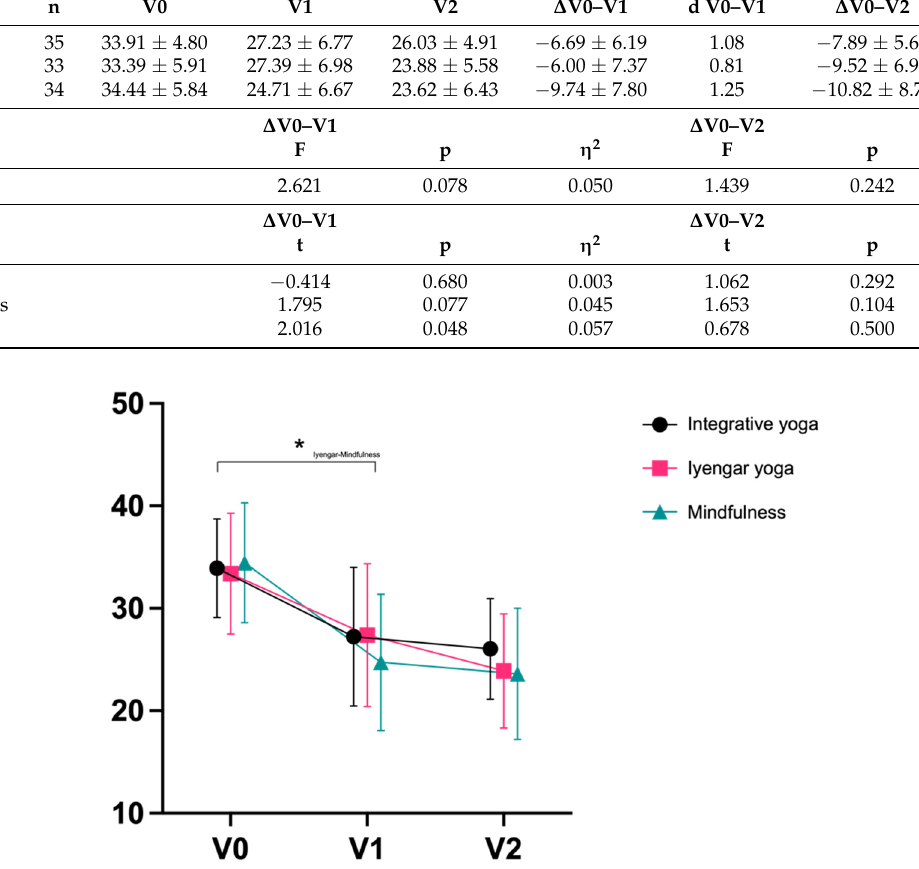
Figure 3. Perceived Stress Scale (Mean ± SD). * = p <0.05